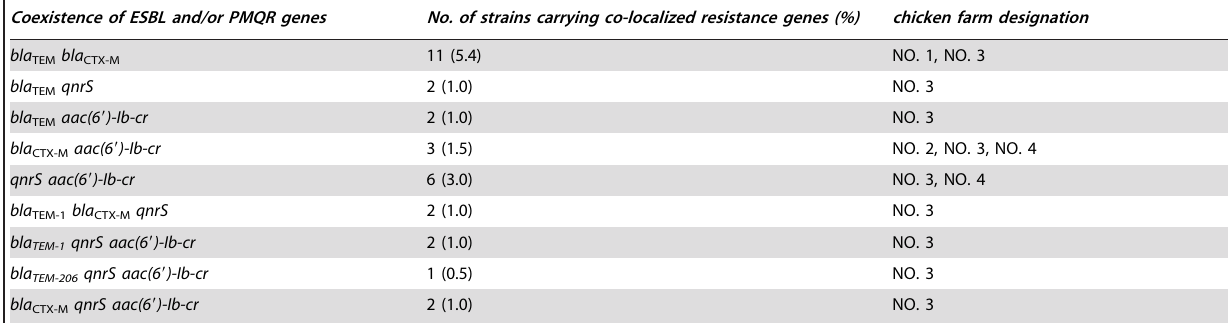
Table 2. Coexistence of ESBL and/or PMQR